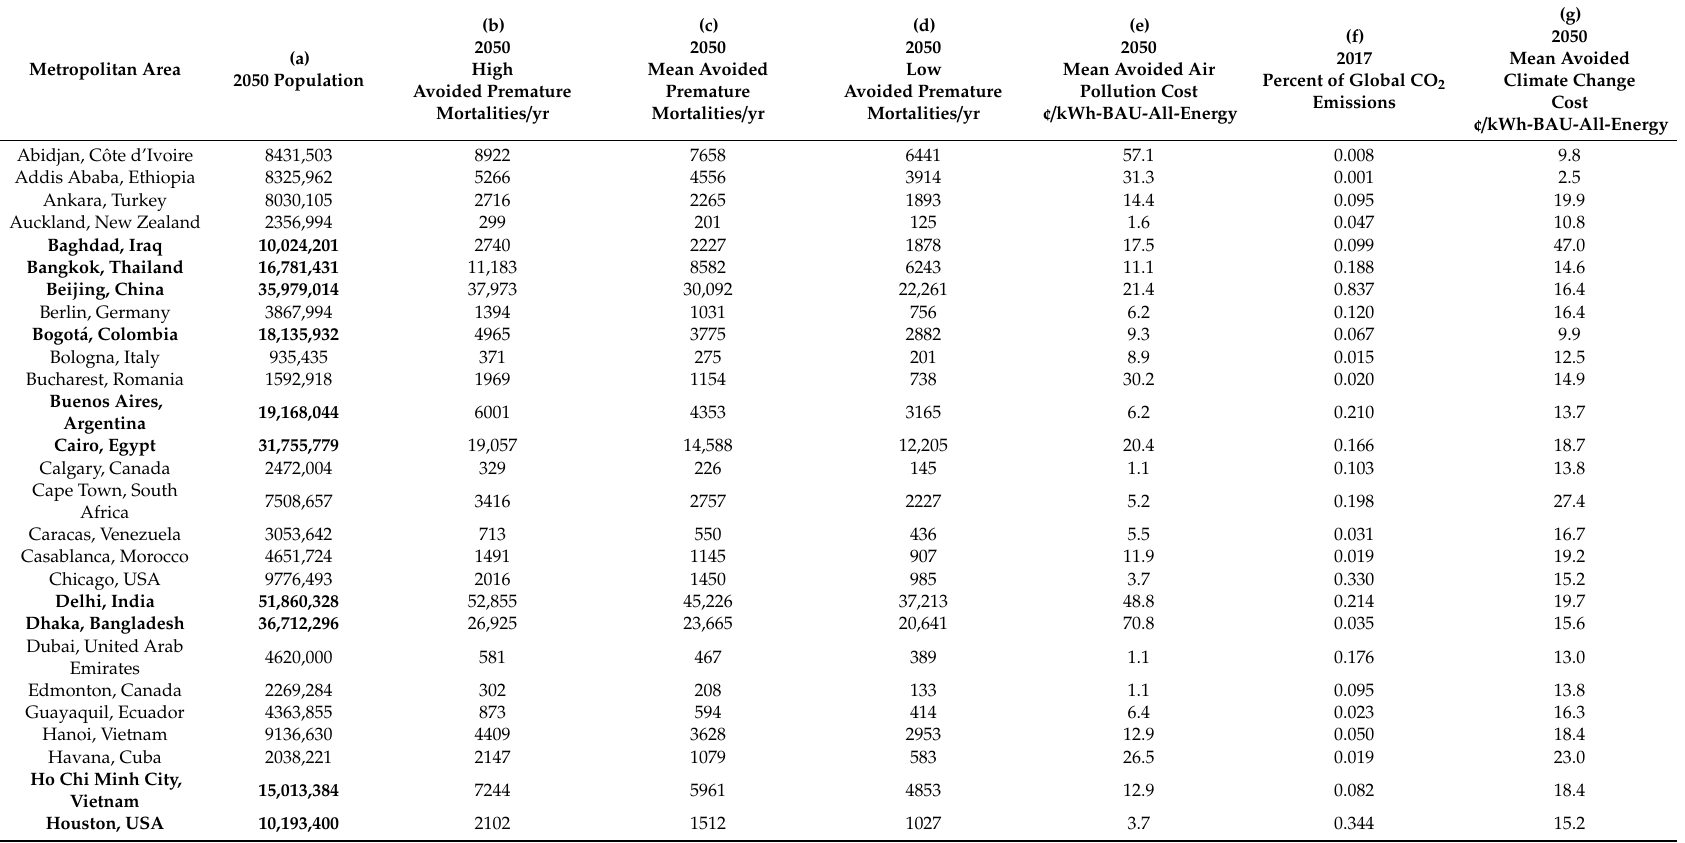
Table 9. ( a ) Year 2050 estimated population by metropolitan area (bold indicates a megacity, whose population exceeds 10 million). Year 2050 ( b ) high, ( c ) mean, and ( d ) low avoided air pollution premature mortalities by metropolitan area due to transitioning to 100% WWS. ( e ) Mean avoided air pollution cost (from avoided mortalities, morbidities, and non-air pollution e ff ects) per unit BAU-energy from all sectors due to converting each metropolitan area to 100% WWS for all energy purposes. ( f ) 2017 estimated percent of global energy-related carbon-dioxide-equivalent (CO 2 e) emissions due to the metropolitan area. 2050. ( g ) 2050 mean avoided climate-change costs to the world per unit BAU-energy from all sectors due to converting each metropolitan area to 100% WWS for all energy purposes. All costs are in 2013